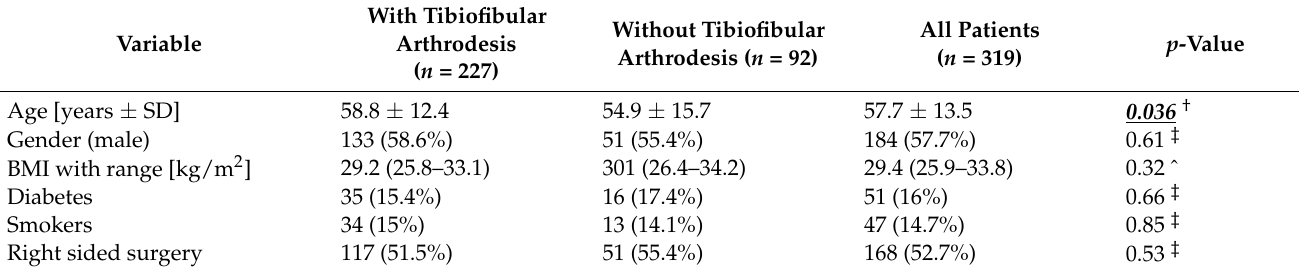
Table 1. Demographic and clinical characteristics.